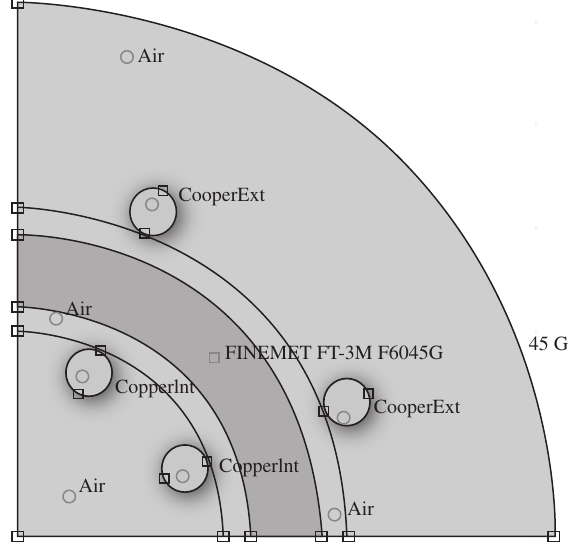
Figure 7. Domain divided in the elements of the